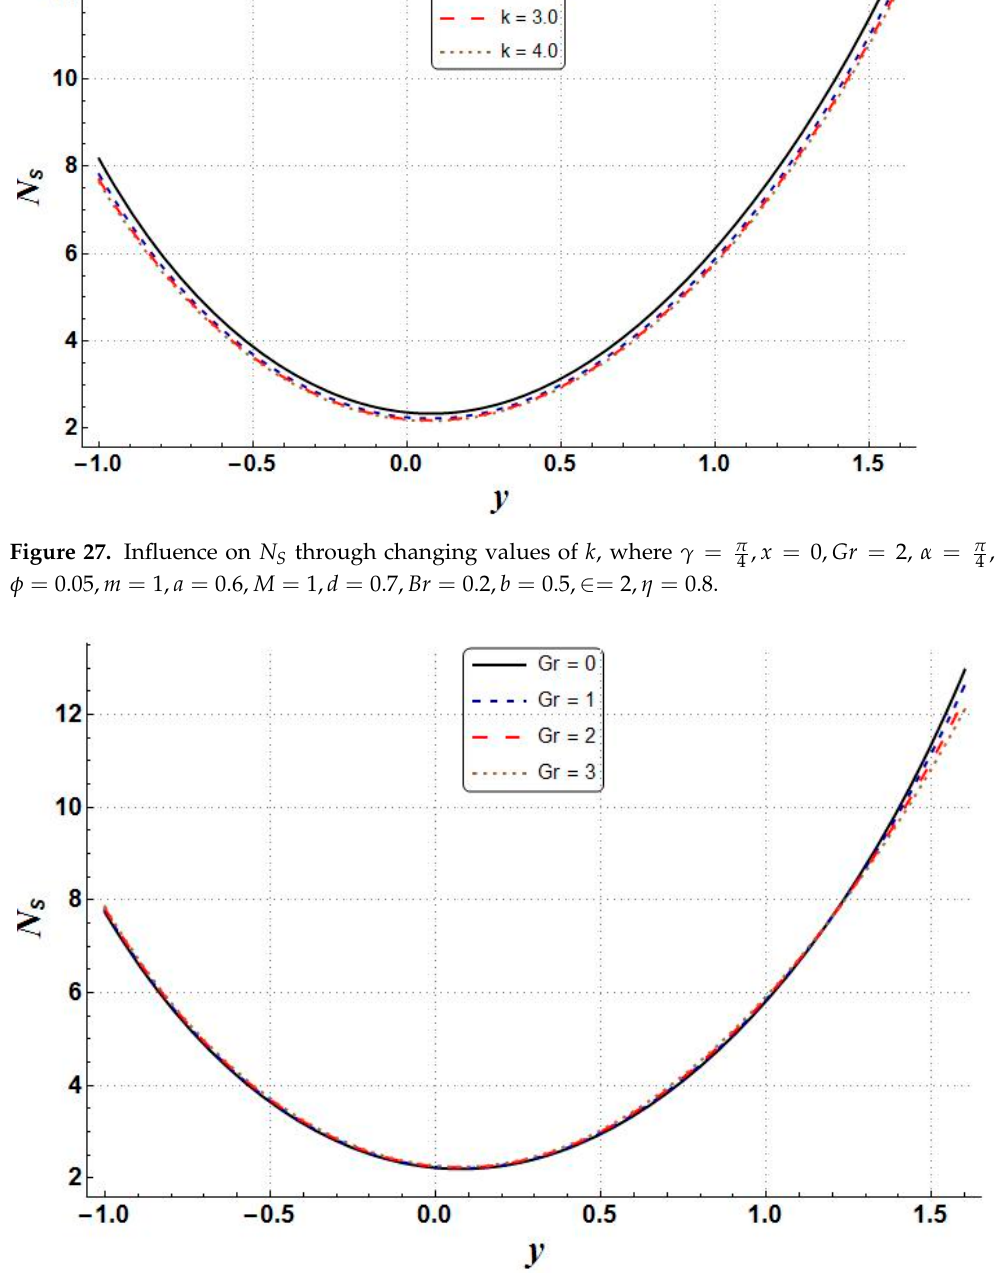
, x = 0, Br = 0.2, 4 , Gr , where , 0, Gr , where